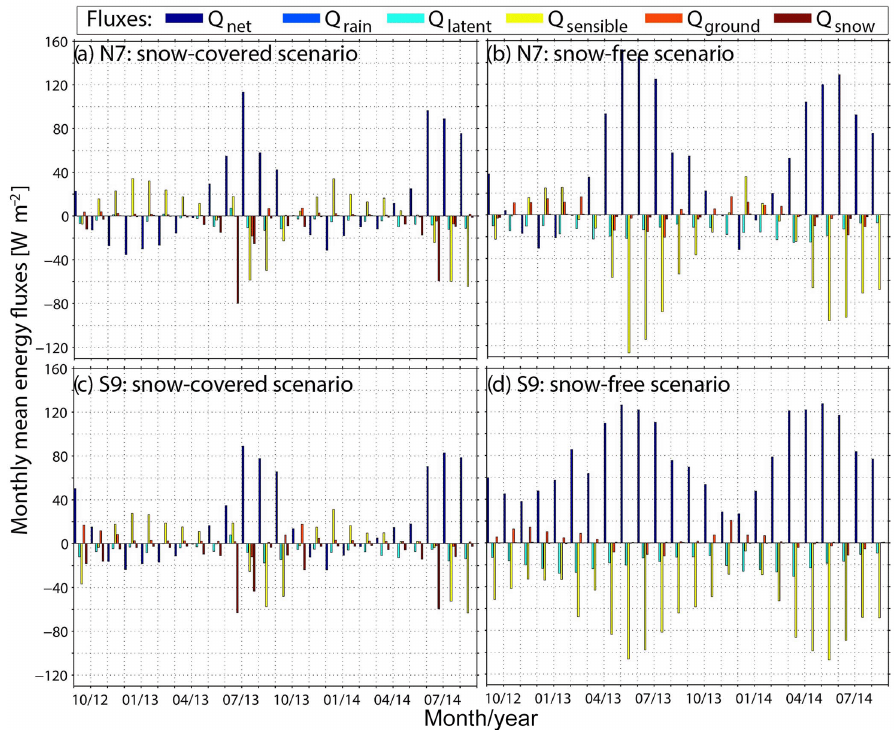
Figure 6. Modelled monthly means of all energy balance components for two selected NSRT locations. N7 (top) faces north-west and S9 (bottom) south-east. To illustrate the influence of the snow cover on the surface energy balance, the energy fluxes are shown for the snow- covered (left) and the snow-free scenarios (right). Energy fluxes are considered positive when directed towards the snowpack surface. Q snow is the energy available to melt the isothermal snowpack and is thus illustrated here as an energy